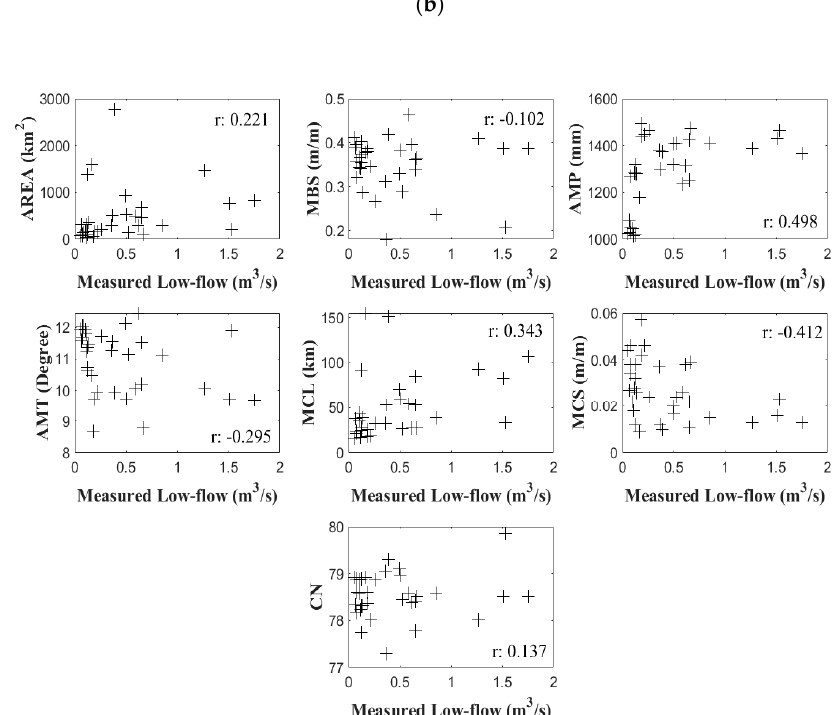
Figure 4. Correlation between physiographical and meteorological variables and ( a ) two-year low-flow quantile and ( b ) five-year low-flow quantile. r indicates the correlation coe ffi cient for each basin. The two-year low-flow quantile plot shows that the river basin descriptors, including AREA, MBS, MCL, CN, and AMP, are positively correlated with low-flows and the other river basin descriptors, namely MCS and AMT, are negatively correlated with low-flows. For the five-year low-flow quantile plot, the observations are similar, except for the MBS. The MCS exhibits a positive correlation with low-flows when divided by the basin area to offset the area effect. The Pearson correlation coefficients of variables range from 0.063 to 0.491 for the two-year quantile and from 0.137 to 0.498 for the five-year quantile. In the RFA process, we used the canonical correlation coefficients, as described in the methodology section. Thus, we also examined the canonical correlation coefficients for the variables to determine the improvements in the correlations between the variables when CCA was applied. The canonical correlation coefficients range from 0.161 to 0.889 for the two- year quantile and from 0.124 to 0.883 for the five-year quantile, as shown in Table 3. In particular, the canonical correlation coefficients for the two-year quantile are high for AREA, MCL, AMP, and AMT compared to the corresponding Pearson correlation coefficients.